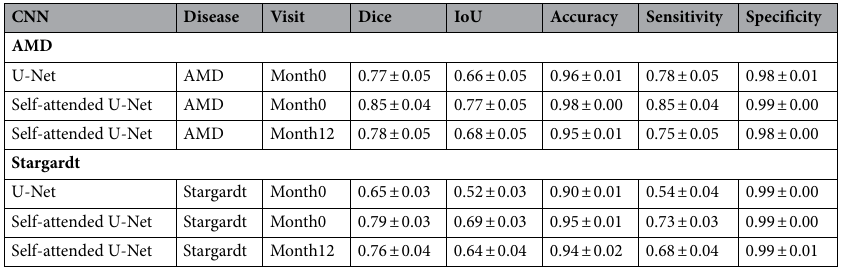
Table 1. Performance results of automated segmentation and prediction of atrophic lesions for eyes with AMD and Stargardt with 95% CIs.